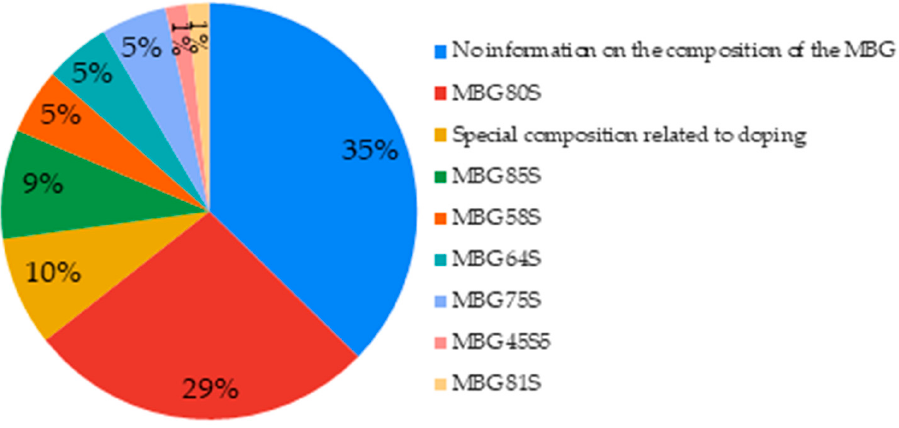
Figure 4. Basic compositions of MBGs used in the studied